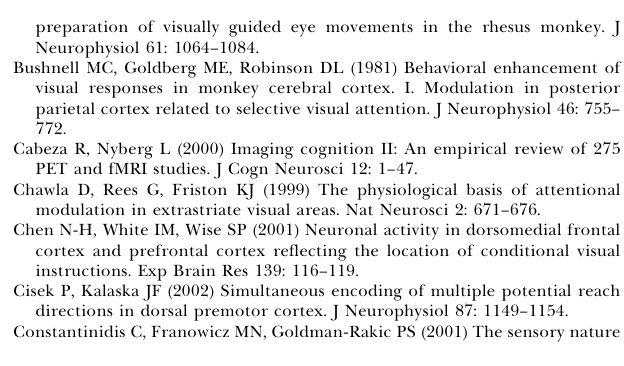
Figure S2. Rasters and Histograms from a Representative Memory Cell The activity matrix is the same as in Figure 3B, measured in the 800 ms prior to the trigger stimulus. Format as in Figure S1. DOI: 10.1371/journal.pbio.0020365.sg002 (95 KB PPT).